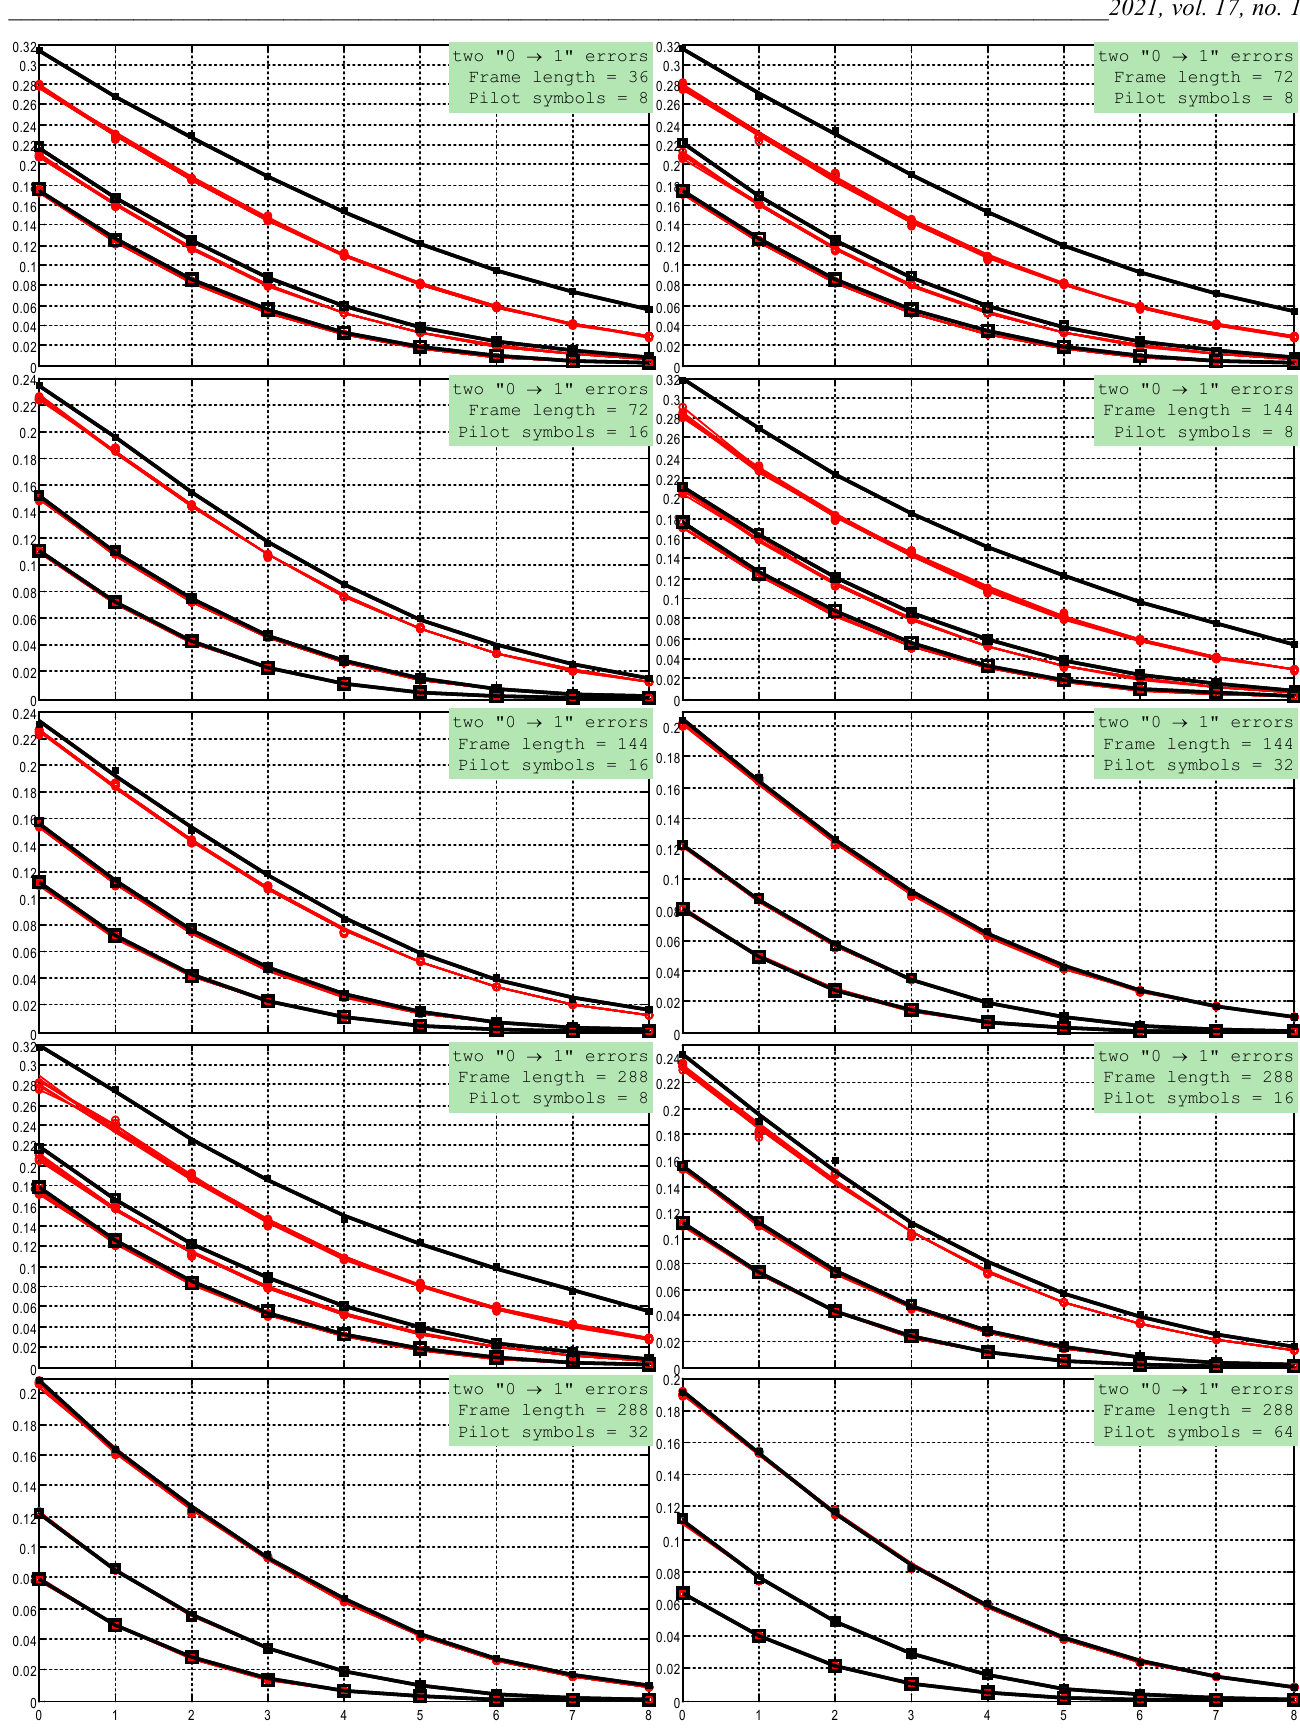
Fig. 7. The BER performance versus BENDR in the case of two repeated pilot sequence symbol errors (“0→1” and “0→1”). This is PSdeO by simulation case